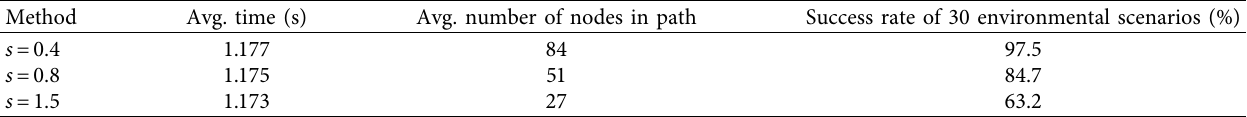
Table 4: Simulation results of s � 0.4, s � 0.8, and s � 1.5 in the same